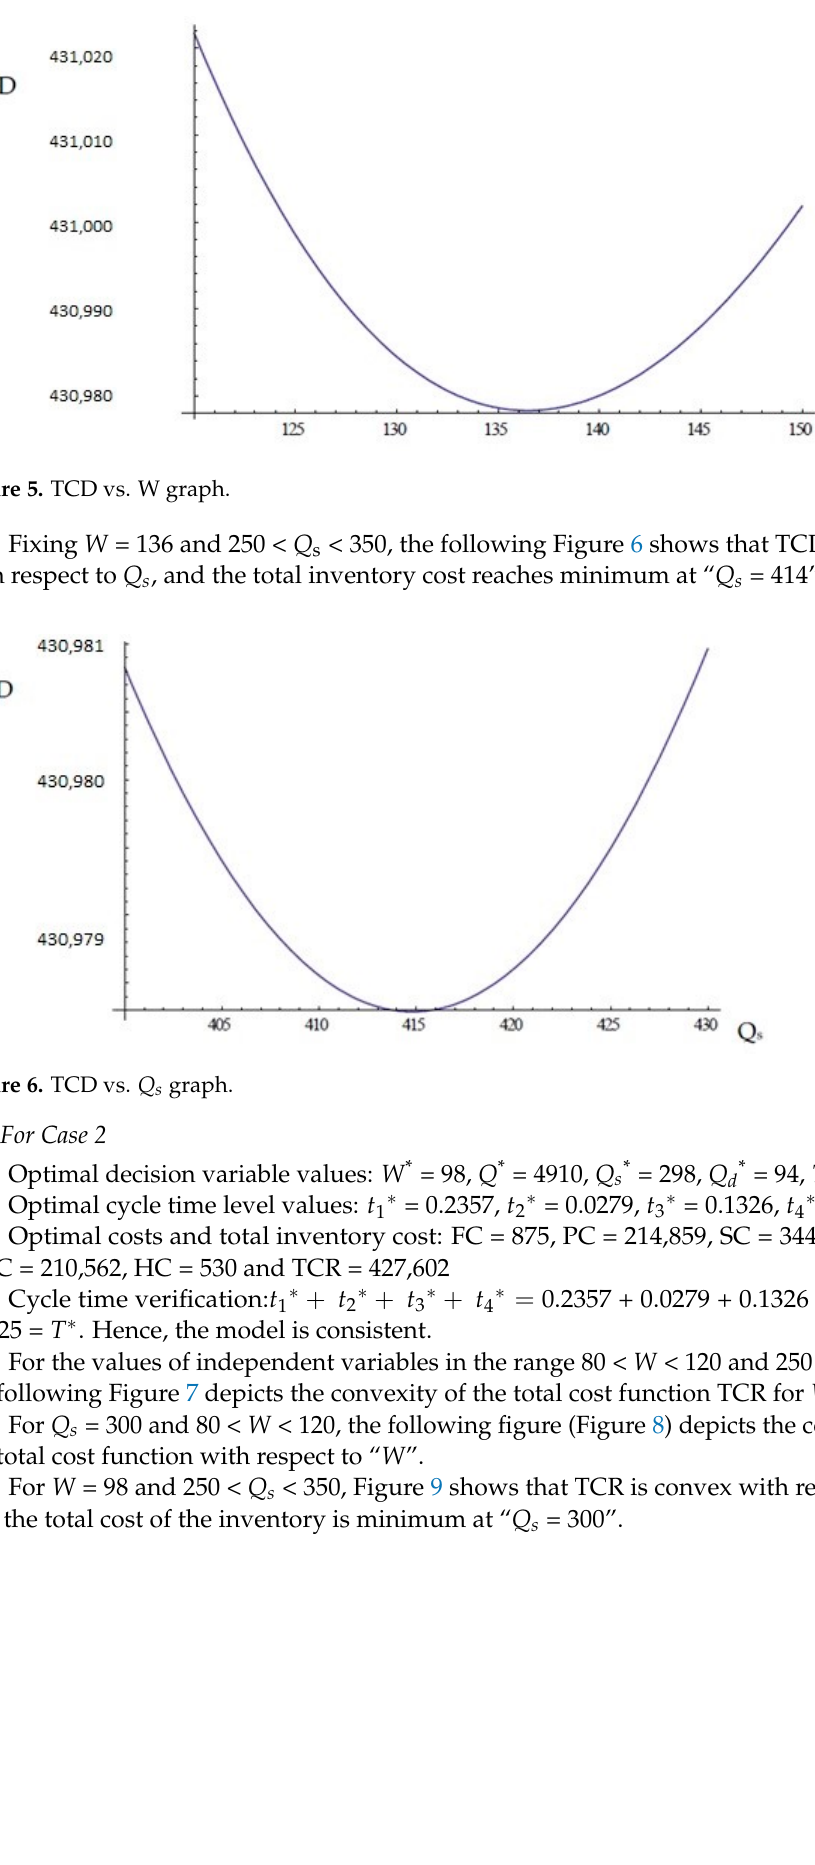
Figure 7. Convexity of TCR relating to W and Q s . For Q s = 300 and 80 < W < 120, the following figure (Figure 8) depicts the convexity of the total cost function with respect to “ W ”.